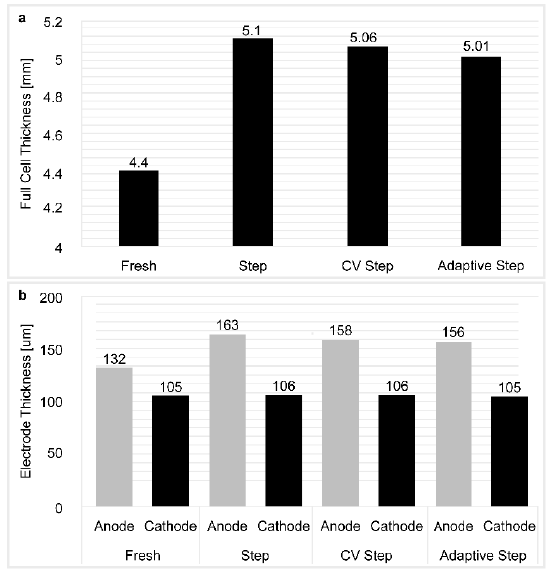
Figure 10. ( a ) Electrode thickness following disassembly; and ( b ) differences in the electrode thicknesses between the positive and negative electrodes.